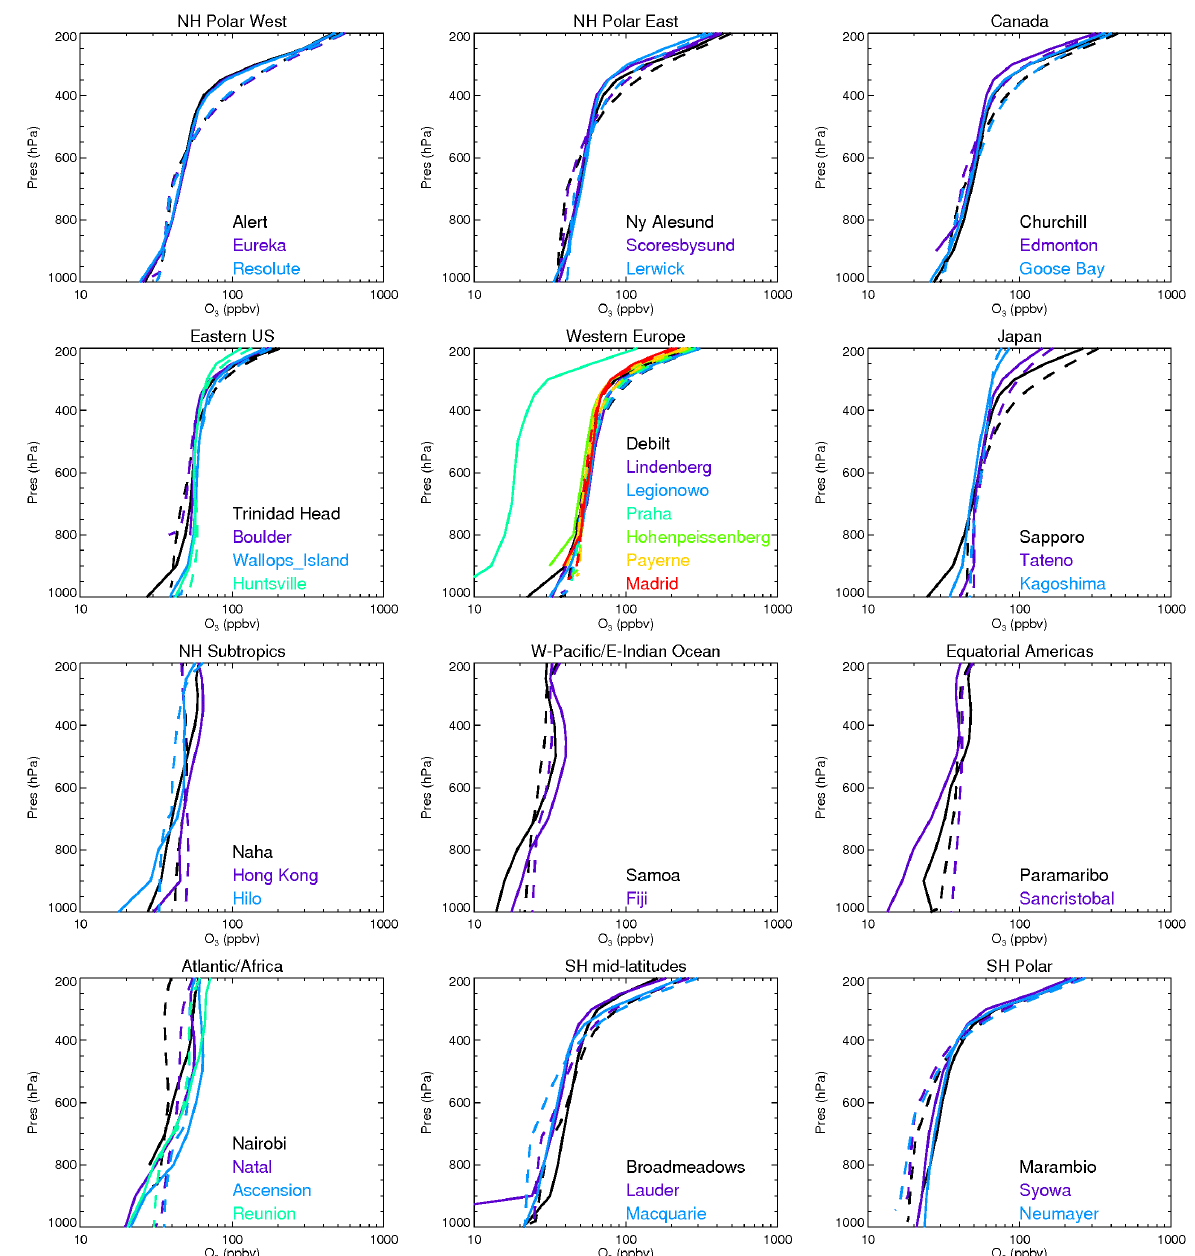
Figure 2. Comparison of observed (solid lines) and simulated (dashed lines) ozone profiles. Observations are taken from ozonesonde obser- vations, and arranged by launch location regions according to Tilmes et al.